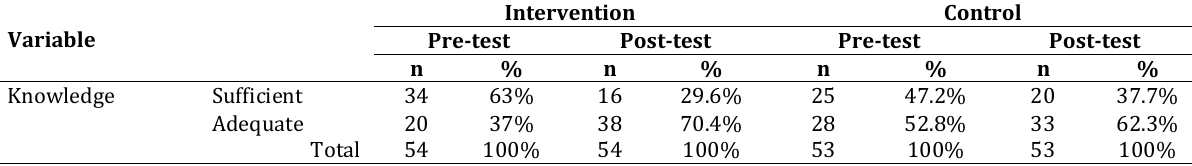
Table 1. The differences of knowledge before and after the Demavi (n=107)